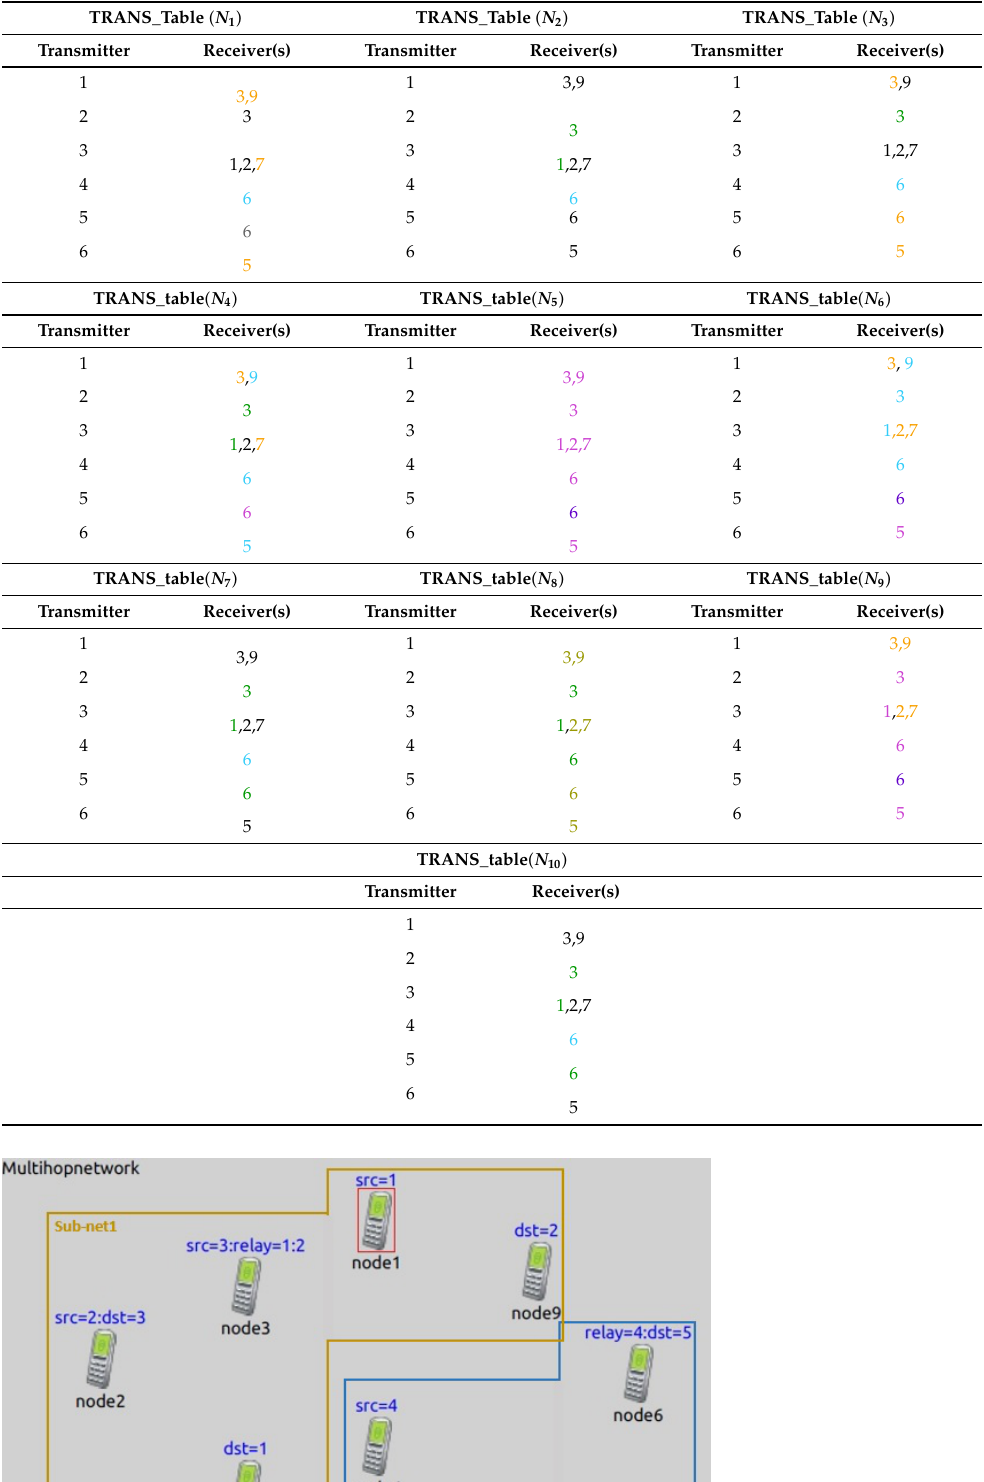
Table 9. Transmission table of all SDRs after completion of the control phase.